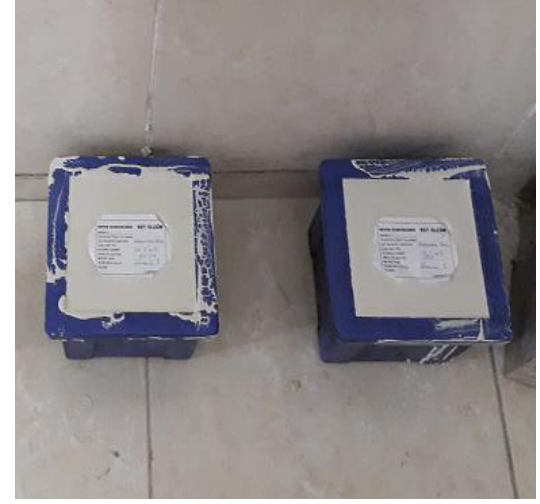
Figure 7. Lime binder mortar for optimum binder fixation.